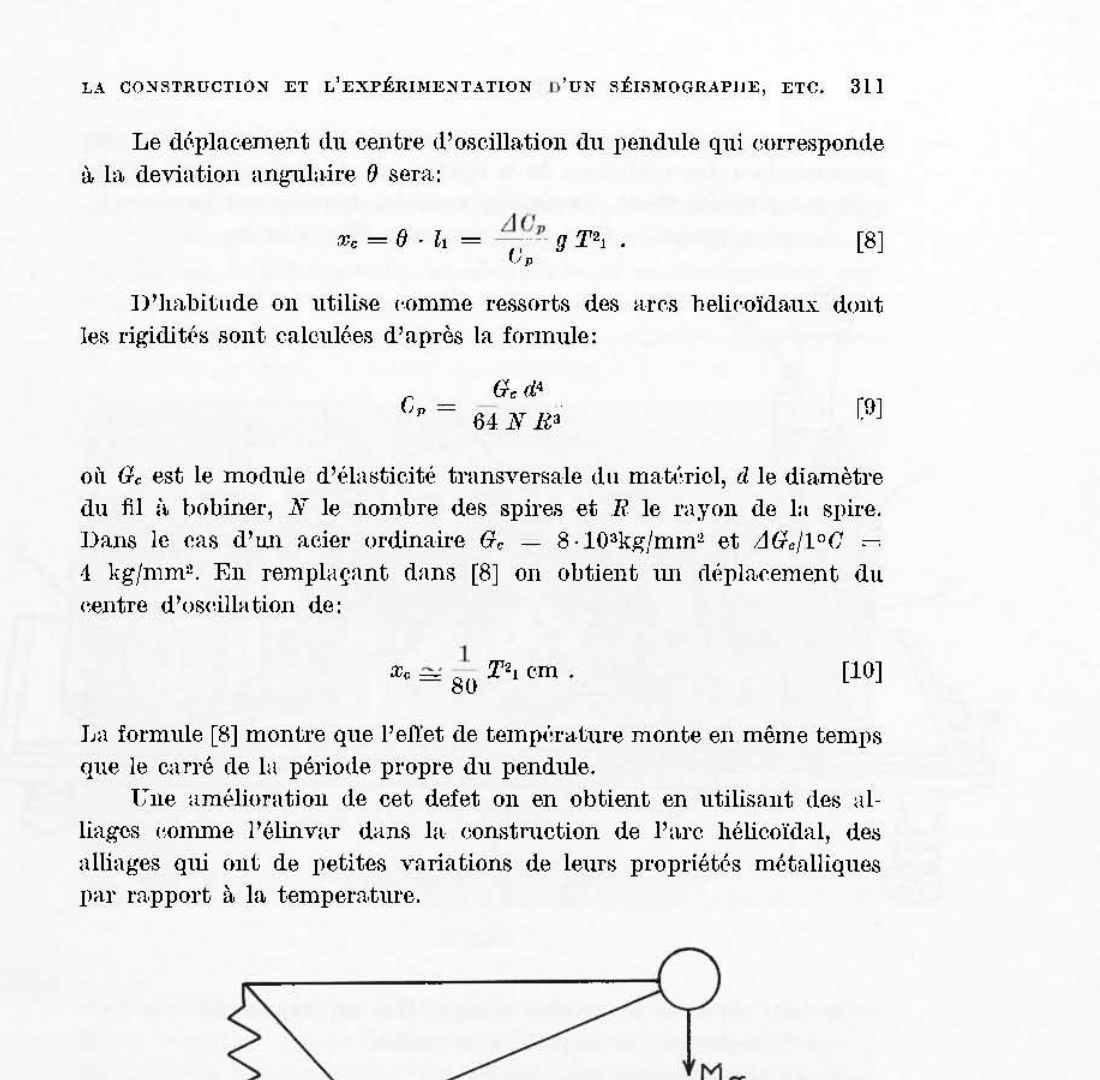
Le d~plaeement du centre d'oseillation du pendule qui